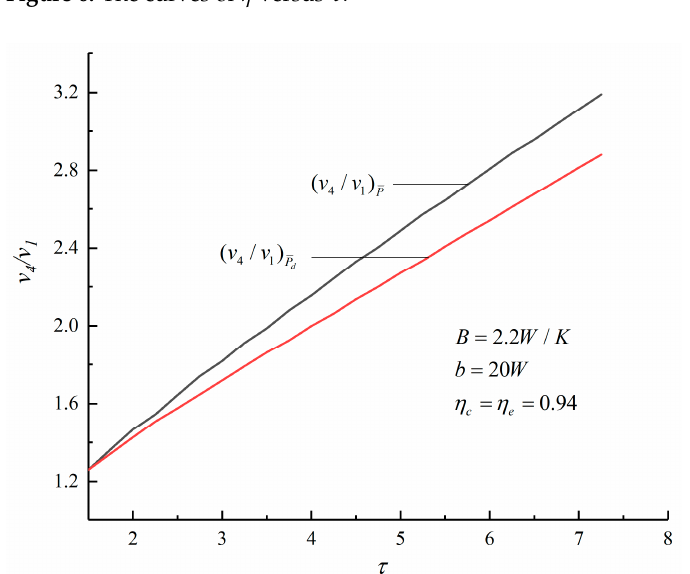
Figure 7. The curves of v 4 / v 1 versus τ .